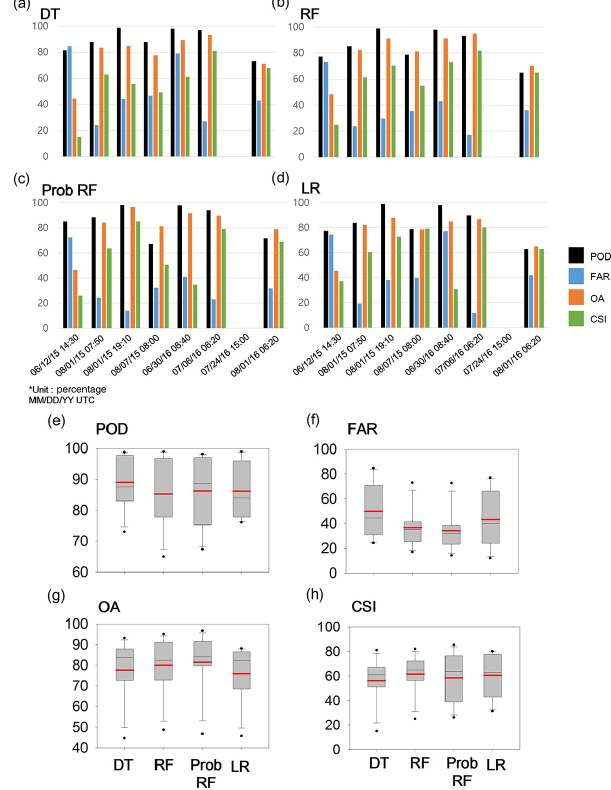
Figure 6. Validation metrics based on lightning data for the (a) de- terministic DT and (b) RF, (c) probabilistic RF, and (d) LR models. Box plots of validation metrics based on lightning data for (e) POD, (f) FAR, (g) OA, and (h) CSI. While red lines in the boxes represent mean values, grey lines represent median